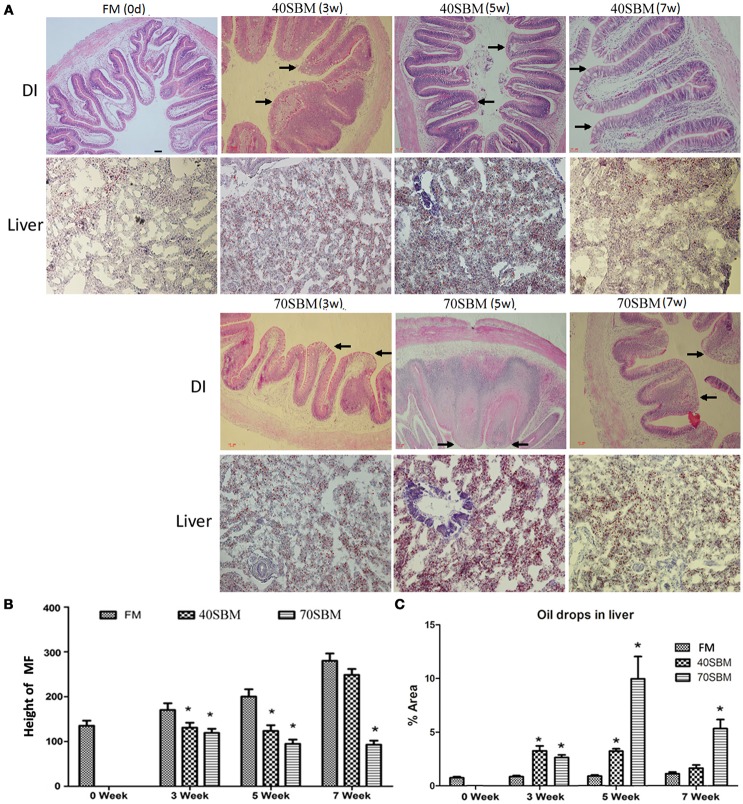
Histological analysis of the gut and liver in tested grass carp. (A) HE staining of DI as well as oil red staining of liver in FM, 40SBM and 70SBM groups at different time points. The typical intestinal folds with less goblet cells, widened LP, shortened MF were indicated by arrows. The chronological change for both the height of the intestinal folds (B) and the area of hepatic oil drops (C) in FM, 40SBM and 70SBM groups. The pixel was classed as an absolute length unit, and percent of area was used for quantification. Eight images per sample were used for qualification for both height of MF and the % area of oil drops. Mean ± S.D. The significant decrease for height of MF as well as significant increase for % area of hepatic oil drops was indicated by stars. The stars represent the significance of the difference between the mean of each bar for either 40SBM or 70SBM compared to FM group.